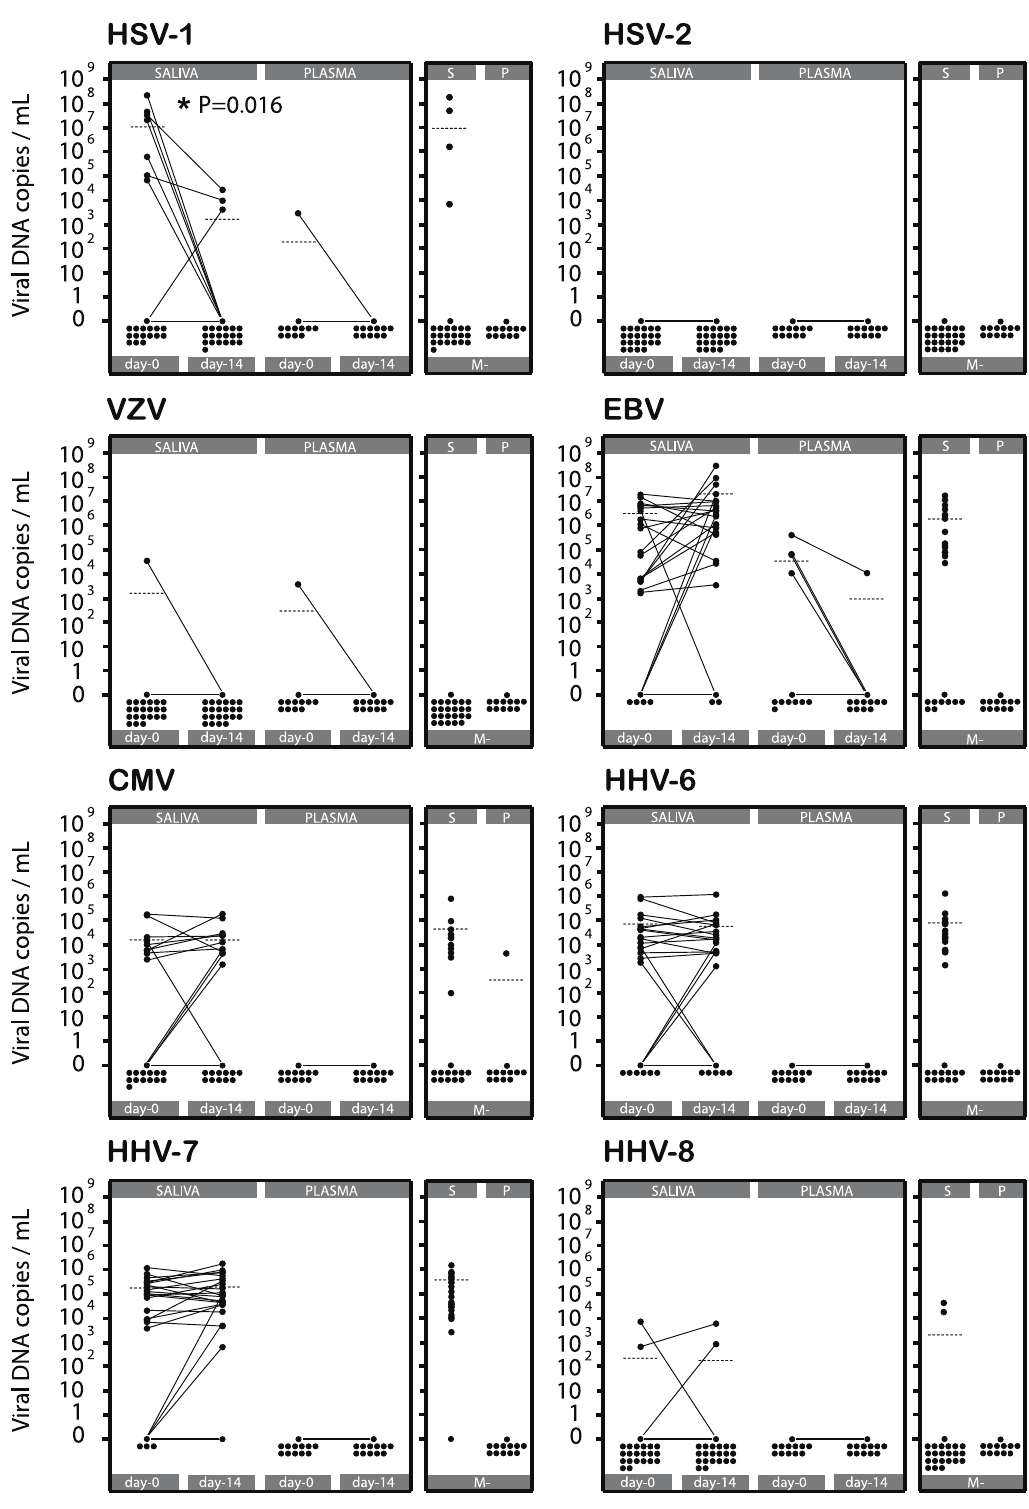
Figure 2. HHVs loads in saliva and plasma before and after anti-malarial treatment. HHVs loads (viral DNA copies/mL) in saliva and plasma samples from children with acute malaria before (day-0) and after (day-14) anti-malarial treatment and in children having mild infections unrelated to malaria (M 2 ). Each black circle represents the viral load for a select HHV for one patient. The black continuous lines link the viral loads of a select HHV at day-0 and at day-14 for the same patient. Paired analysis between the M + day-0 and M + day-14 samples were performed using the Wilcoxon Signed-Ranks Test. P , 0.05 was considered to be statistically significant. The dashed horizontal lines represent the mean viral load for a select HHV in each group. All samples with less than 200 viral DNA copies/mL were considered negative.